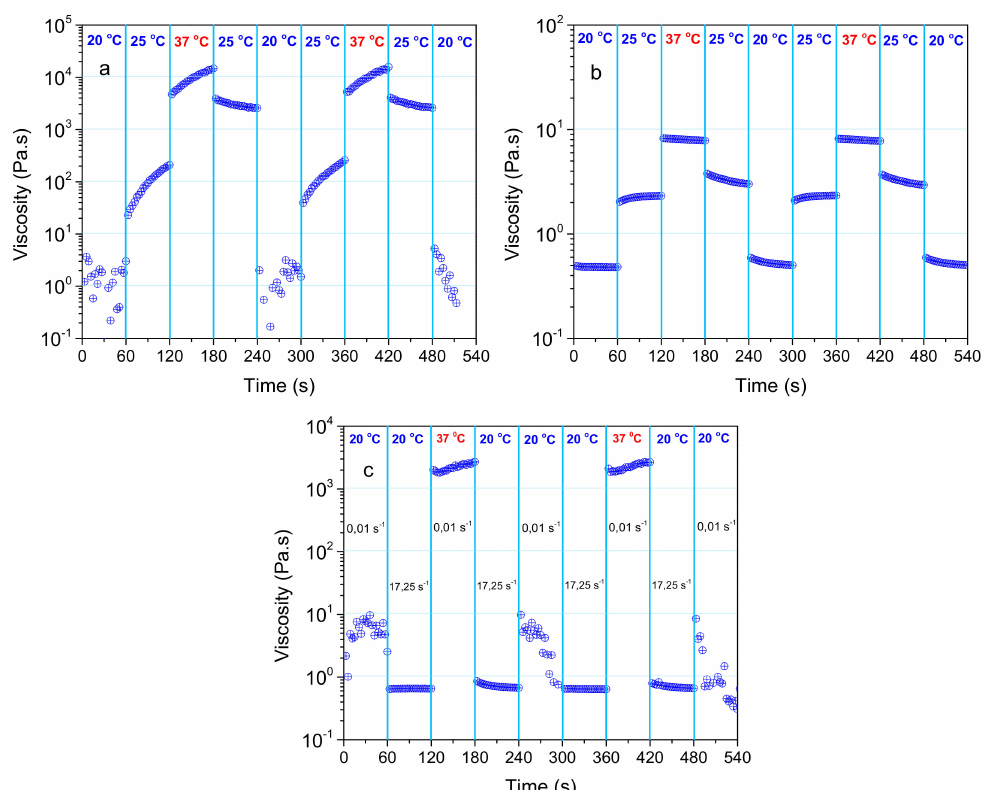
Figure 7. Shear viscosity versus time of a 5 wt% NaALG- g -P(NIPAM 80 - co -NtBAM 20 ) aqueous solution subjected to stepwise temperature switch at a constant shear rate of 0.01 s − 1 ( a ) and of 17.25 s − 1 ( b ). In ( c ), the sample was subjected to consecutive conditions by simultaneously varying shear rate and temperature, e.g., from 0.01 s − 1 / 20 ◦ C to 17.25 s − 1 / 20 ◦ C to 0.01 s − 1 / 37 ◦ C in three